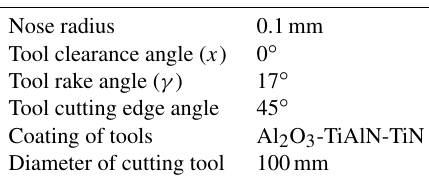
Table 1. Detailed parameters of the coated tool for CGI.